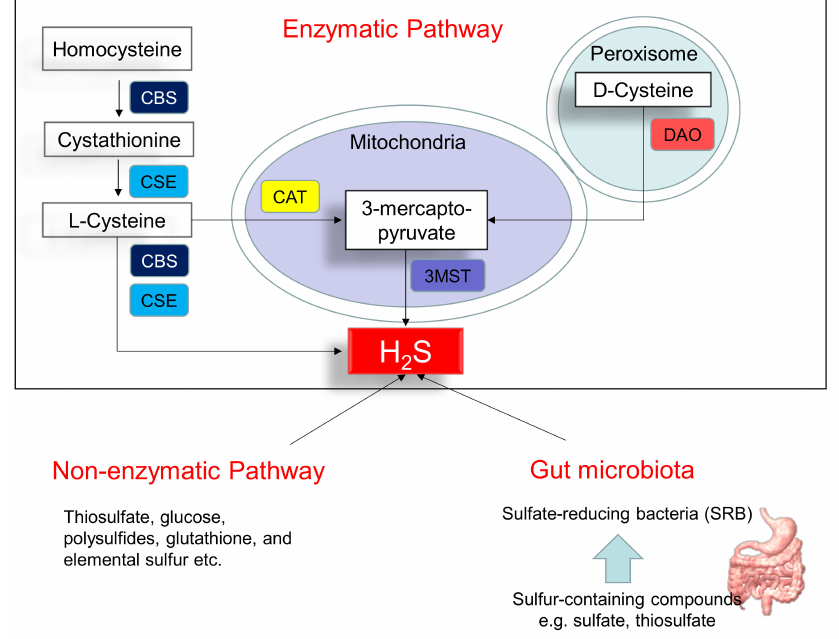
Figure 1. Schematic representation of three major sources of H 2 S: enzymatic pathway, nonenzy- matic pathway, and bacterial origins. Cystathionine β -synthase (CBS) catalyzes homocysteine to produce Cystathionine. Cystathionine γ -lyase (CSE) catalyzes cystathionine to form L -cysteine or L -cysteine to generate H 2 S. 3-Mercaptopyruvate sulfurtransferase (3MST) produces H 2 S from 3- mercaptopyruvate, which is generated by cysteine aminotransferase (CAT) and D -amino acid oxidase (DAO) from L -cysteine and D -cysteine, respectively. Another source of endogenous H 2 S is coming from nonenzymatic processes. The other source of H 2 S is derived from gut microbes, mainly by the sulfate-reducing bacteria